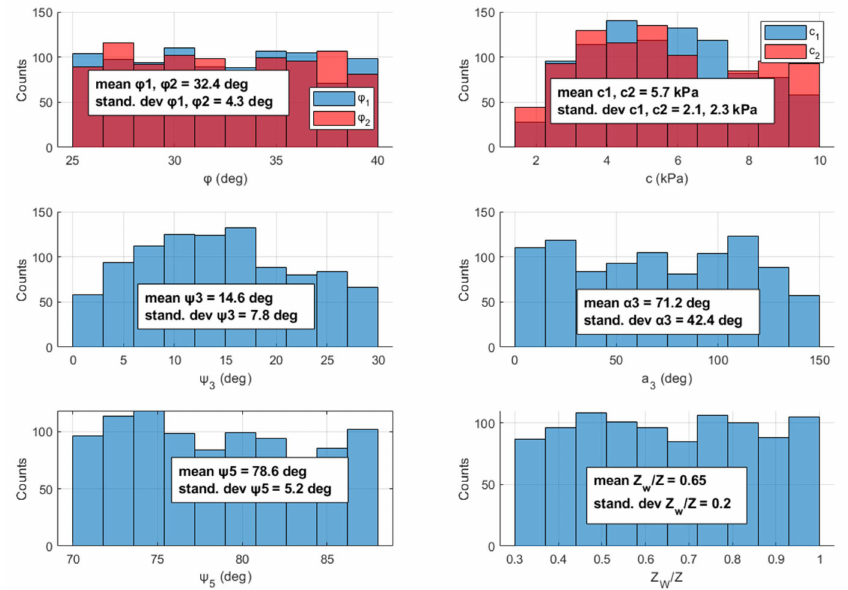
Figure 8. Results of back-analysis procedure for the critical plane intersections of wedge sliding, in terms of material strength properties of discontinuities and geometrical features of slopes, for slope dip direction ranging between 128 ◦ and 140 ◦ .